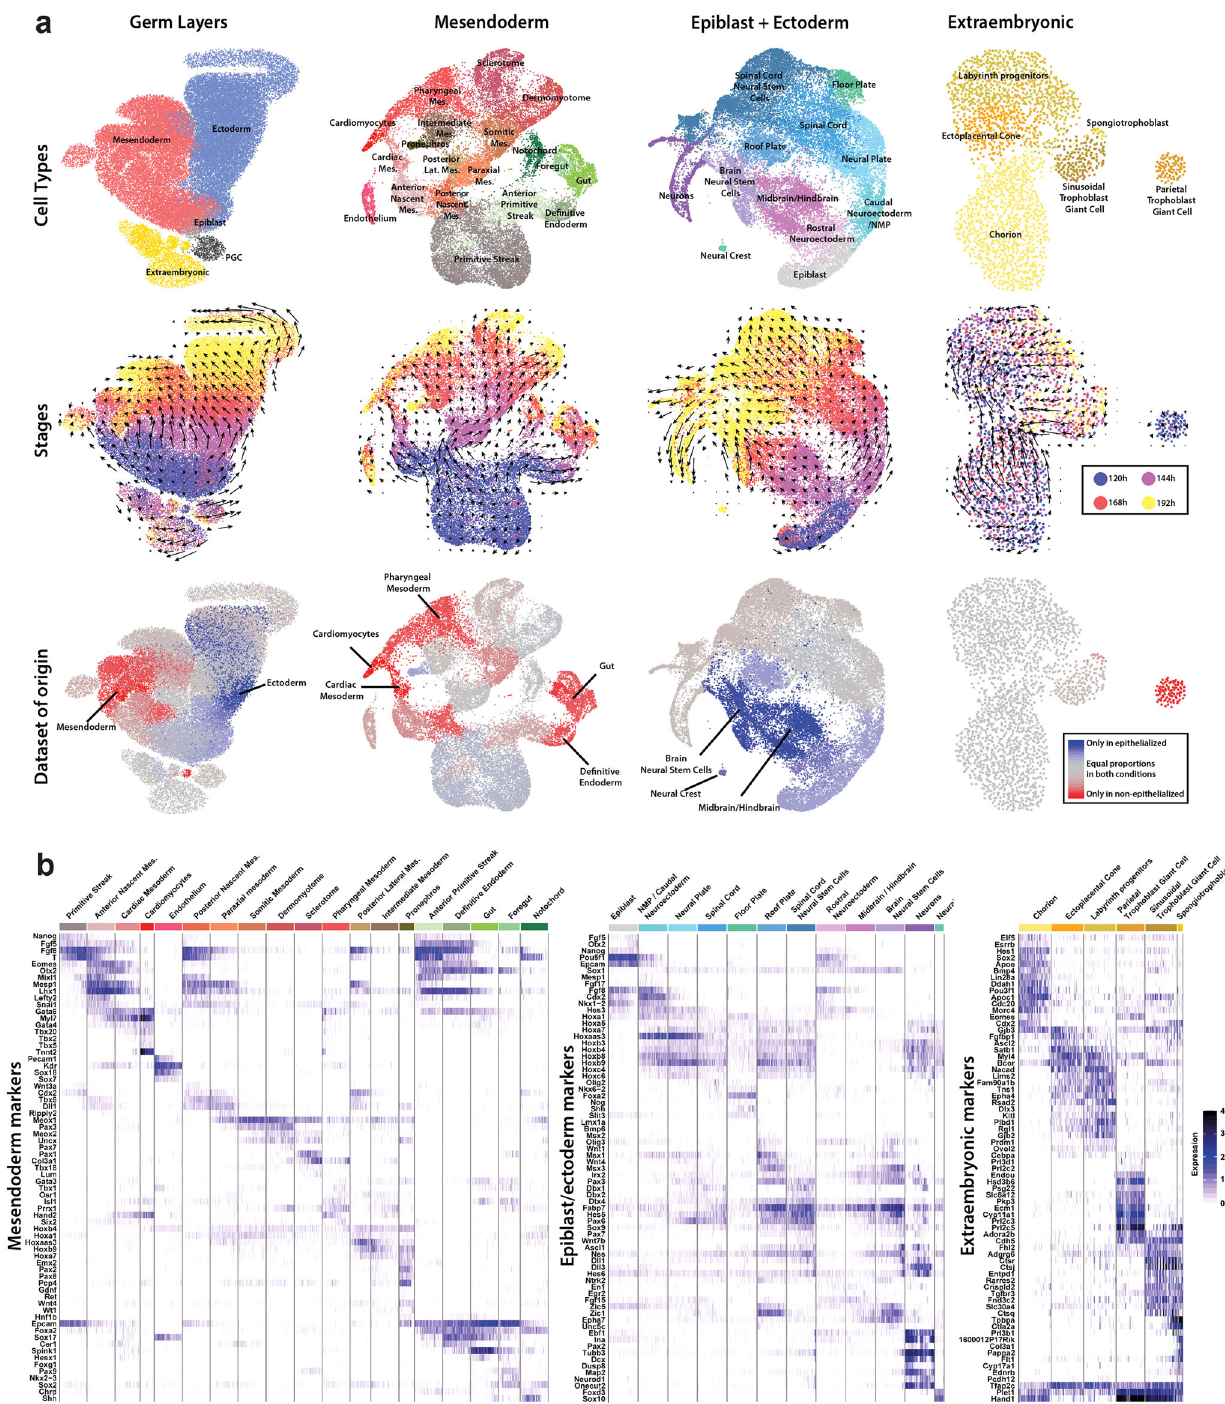
Fig. 5 Comparative single-cell RNA-sequencing analysis of EpiTS embryoids. a UMAP plots showing cell types, RNA velocity overlayed stages, and datasets of origins in germ layers, mesendoderm, epiblast + ectoderm, and extraembryonic clusters. b Heatmap plot of selected marker genes from mesendoderm, epiblast + ectoderm, and extraembryonic clusters. PGC primordial germ cells, Lat. lateral, Mes. mesoderm.